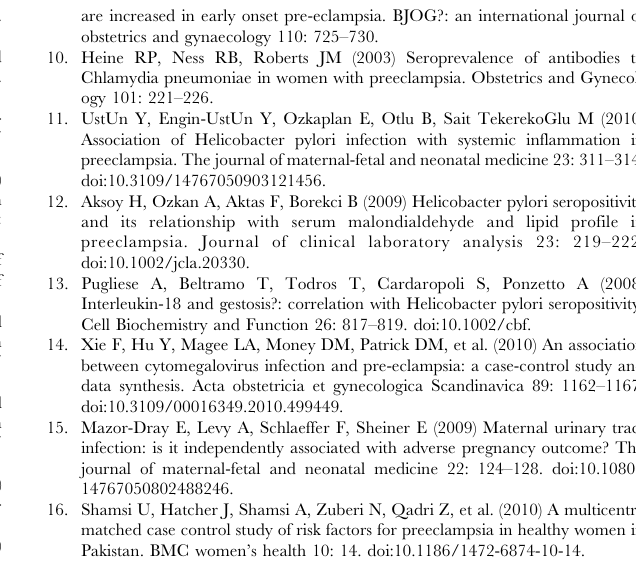
Table S2 Episodes of exposure to maternal infection or antibiotic treatment in pregnancy. Table S3 Adjusted odds ratios for early-onset ( , 34 weeks’ gestation) and late-onset ( $ 34 weeks’ gestation) pre-eclampsia. Table S4 Results of sensitivity